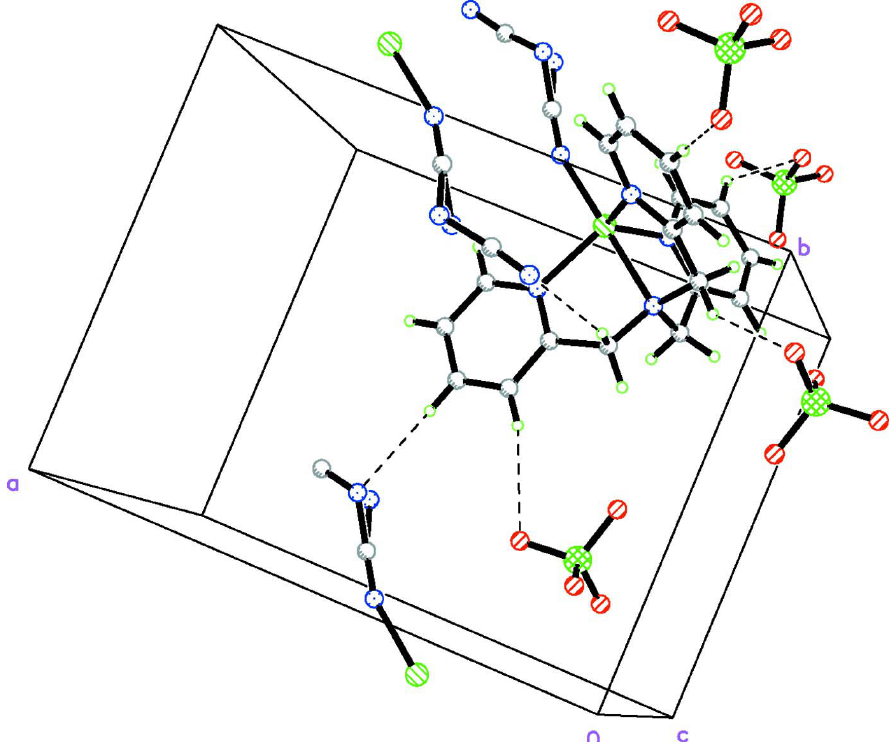
Figure 2 Part of the crystal structure showing weak hydrogen bonds as dashed